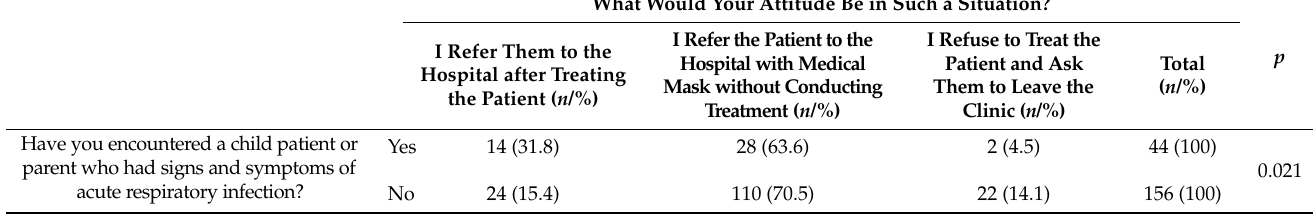
Table 6. Attitudes of participants when faced with a child patient or parent who had signs and symptoms of acute respiratory infection.